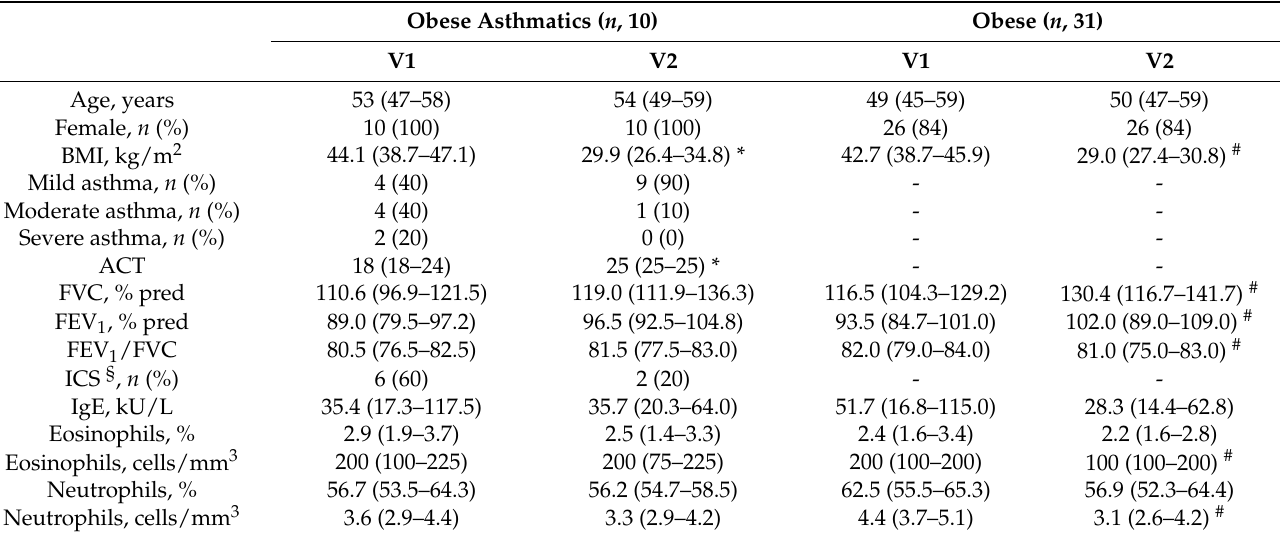
Table 2. Demographic and clinical data of asthmatic and non-asthmatic obese patients before (V1) and six to twelve-months after (V2) bariatric